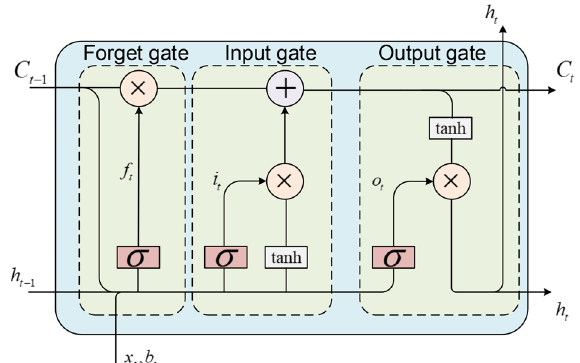
Figure 3. Structure of the LSTM